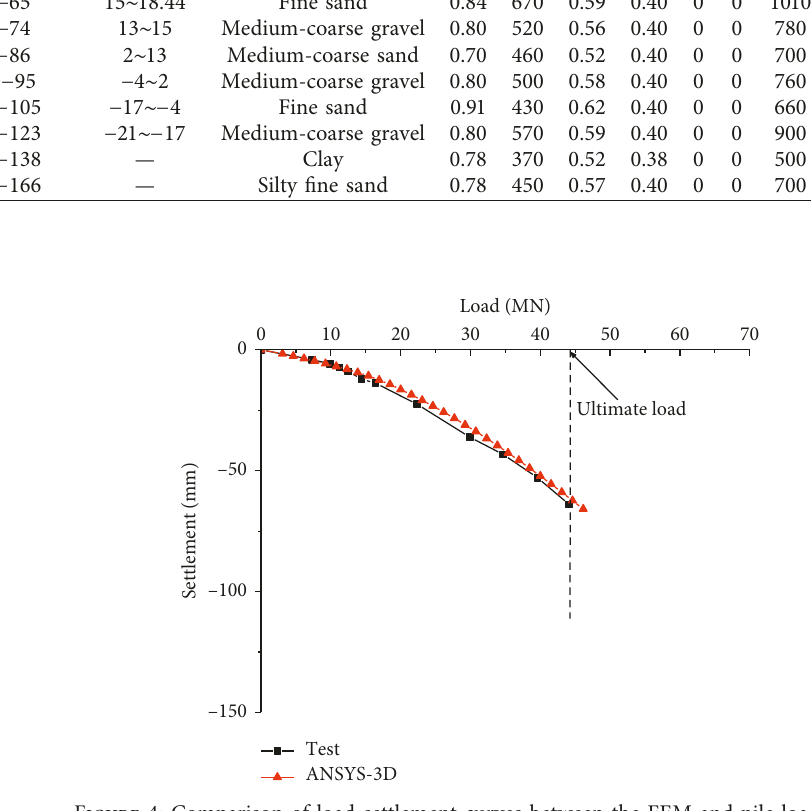
Figure 4: Comparison of load-settlement curves between the FEM and pile load